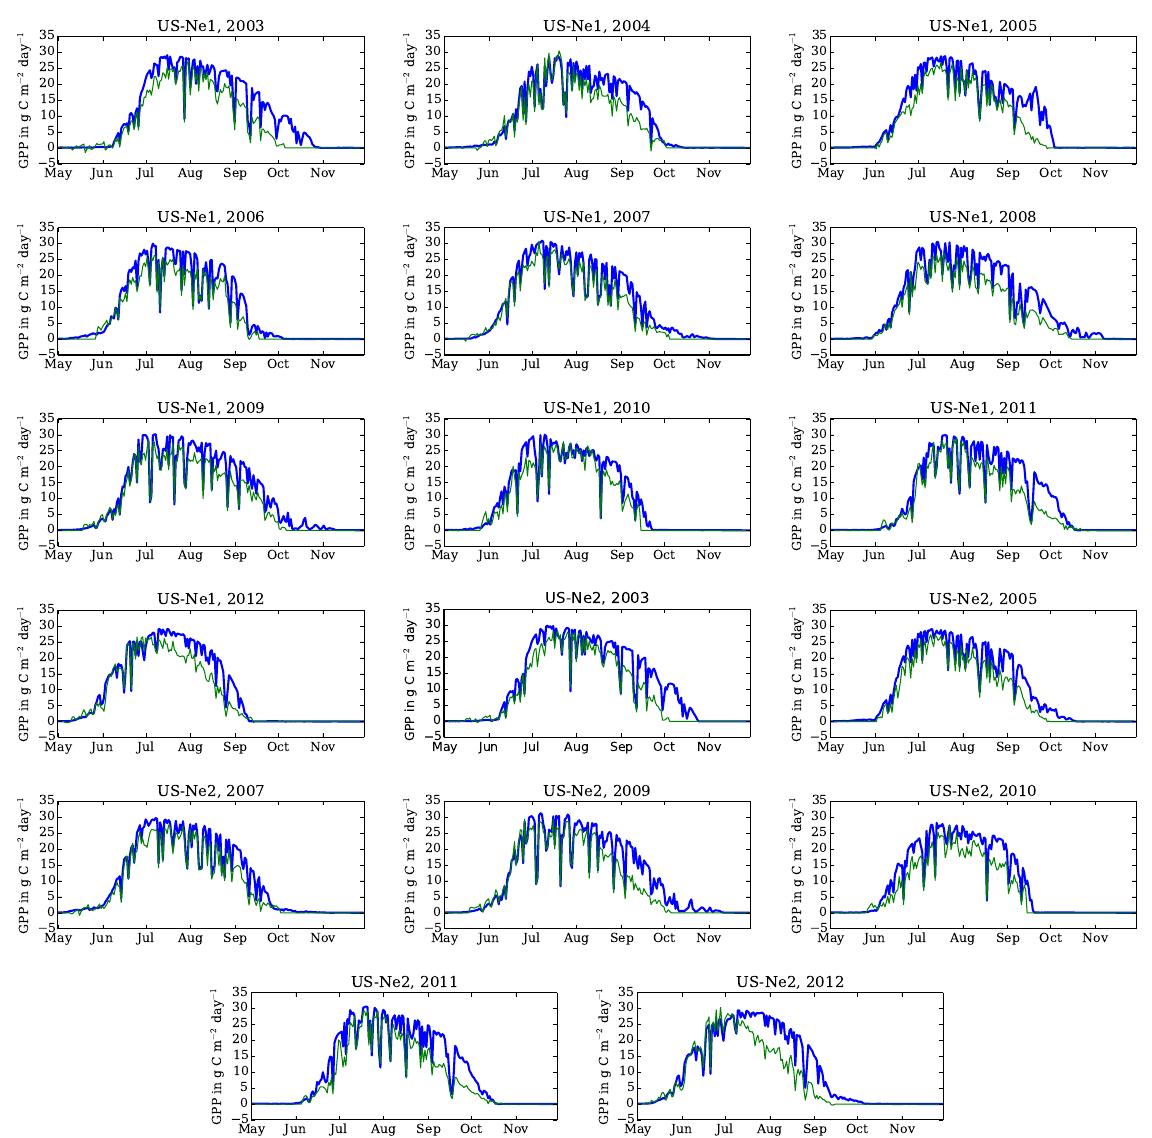
Figure 18. Time series of GPP for irrigated maize at the Mead FLUXNET sites US-Ne1 and US-Ne2; blue: model; green: observations. JULES runs have the crop model switched off, LAI and canopy height prescribed and the input parameters in Tables 1, 2, 3, and 4.